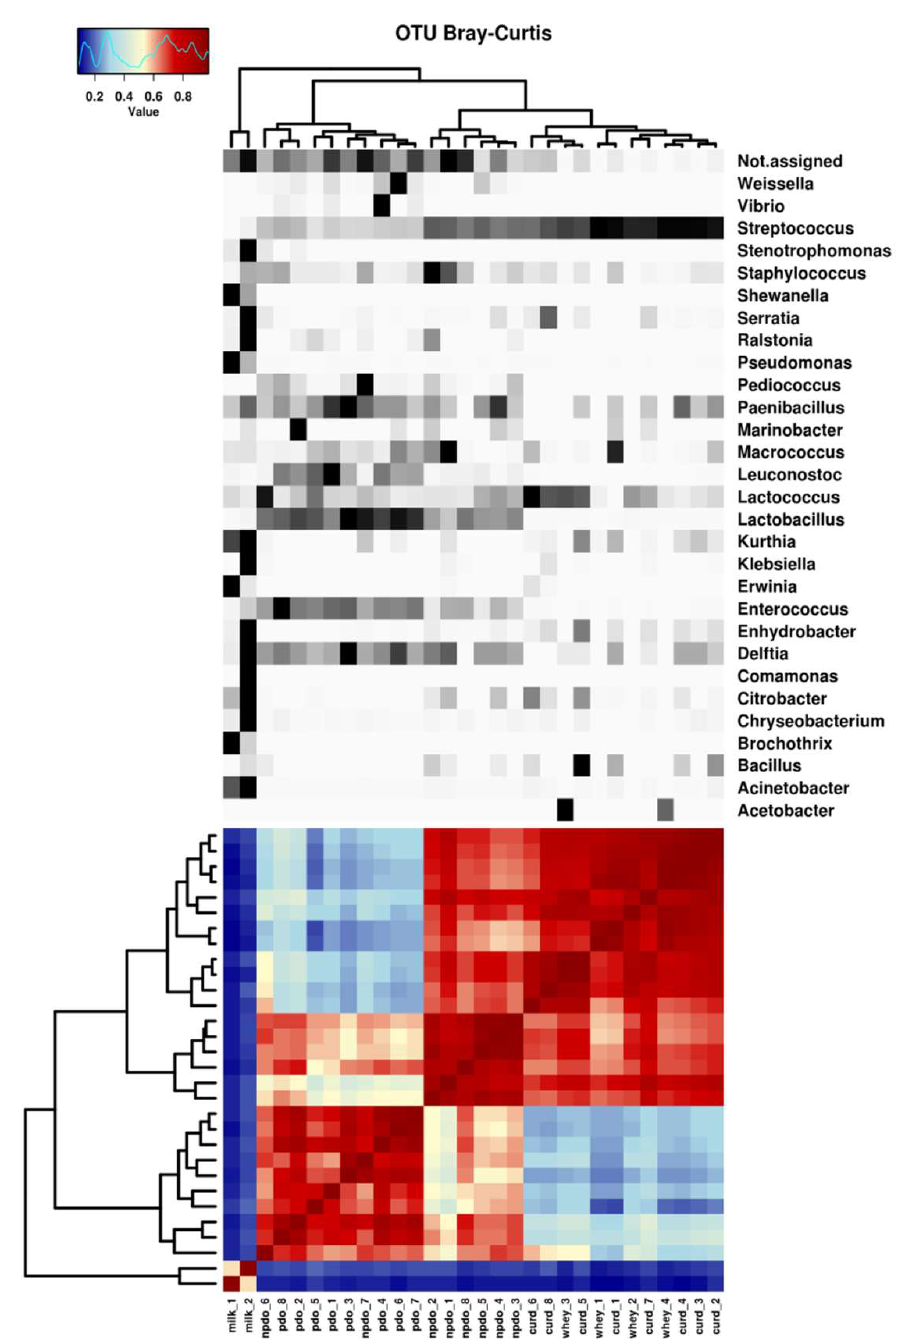
Figure 3. Dendrogram and heat map representing the distribution (%) of bacterial genera in samples of milk, whey (NWS), curd, non-PDO cheeses (nPDO) and PDO cheeses (PDO). Only OTUs that occur with an abundance of more than 0.1% in at least one sample were included. The grouping of the samples was obtained by hierarchical clustering. The color code, from blue to red, indicates the Bray–Curtis distance metric, where the color blue represents maximum dissimilarity and red shows maximum similarity. In the upper part, the color code indicates the relative abundance of OTUs in the sample, ranging from white (low abundance) to black (high abundance).